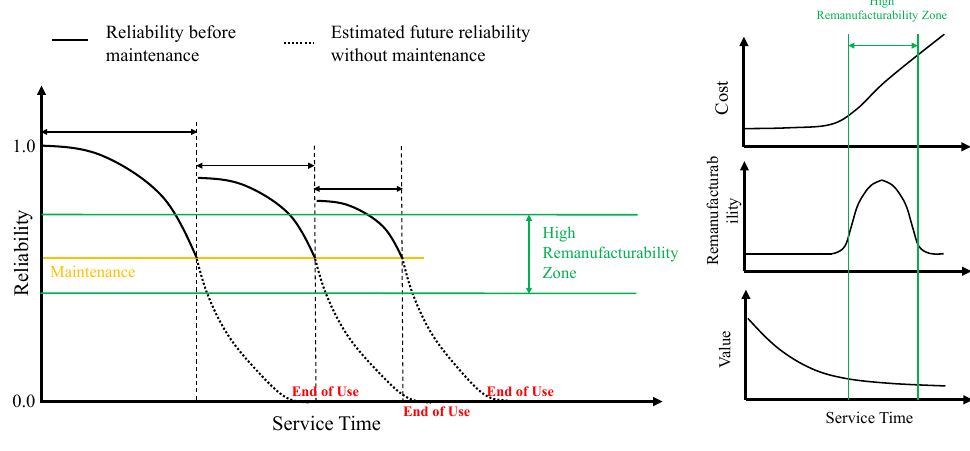
Figure 1. The relationship between remaufacturability and predictive